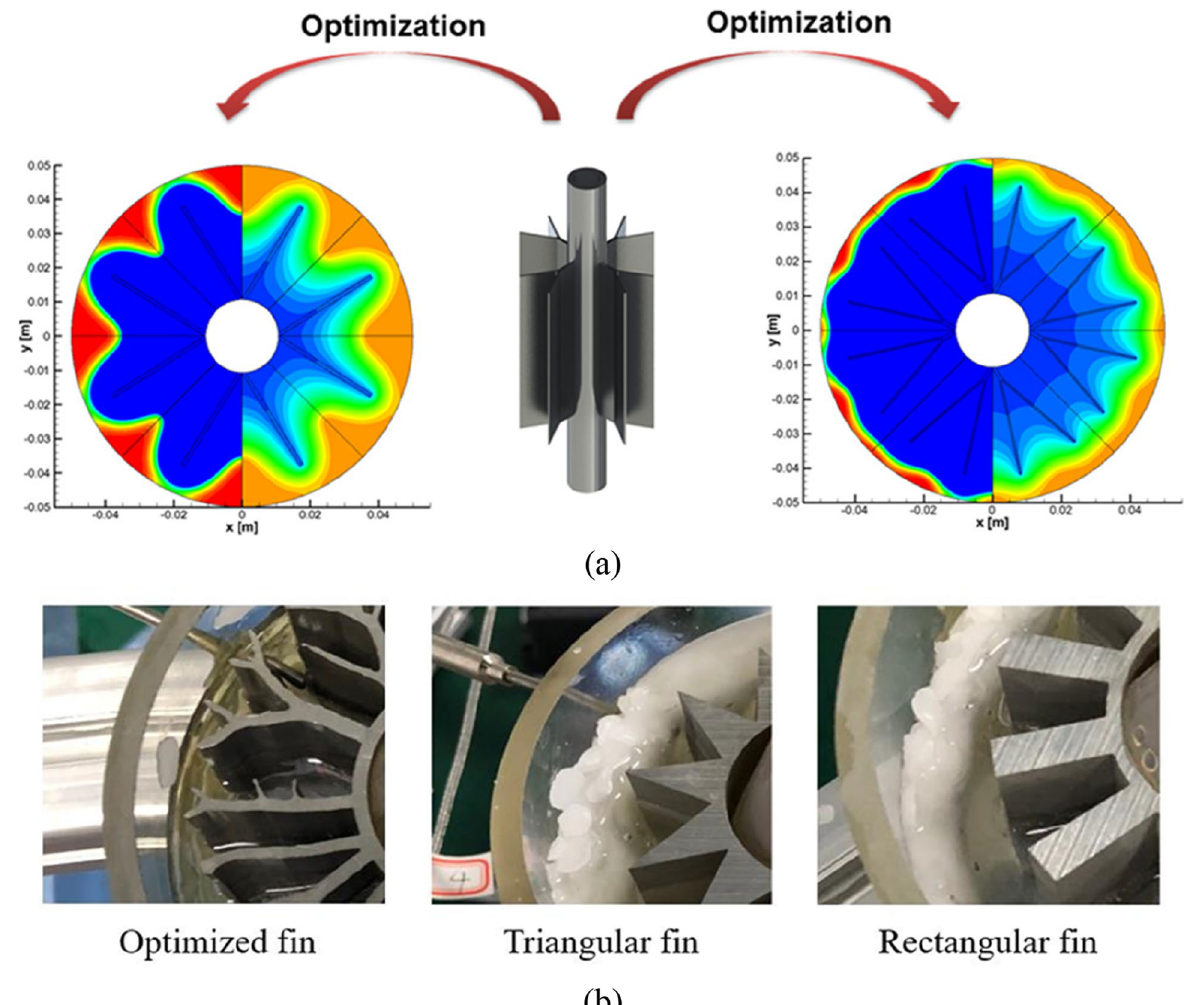
Fig. 5 Optimal fin design, and corresponding temperature and liquid fraction distributions: a response surface method and c experimental validation of topology optimization [135,